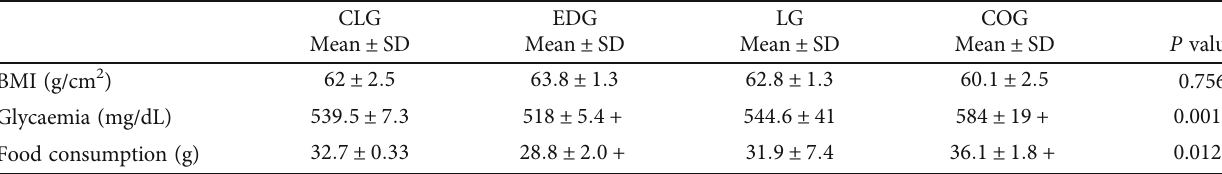
Table 3: BMI, glycaemia, and food consumption in db/db mice supplemented with EPA/DHA derived from microalgae and coconut oil. CLG EDG